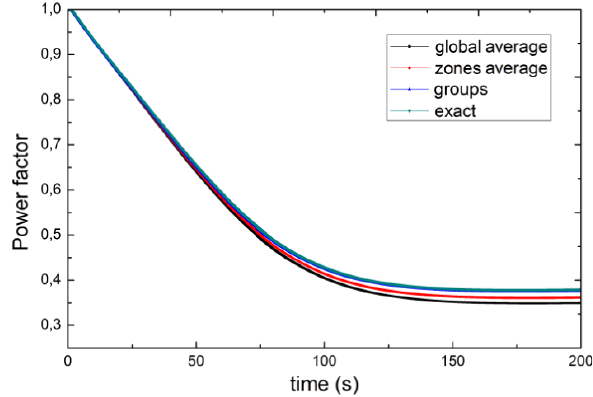
Fig. 9. Power during ULOF/PP accident for different thermal properties models.